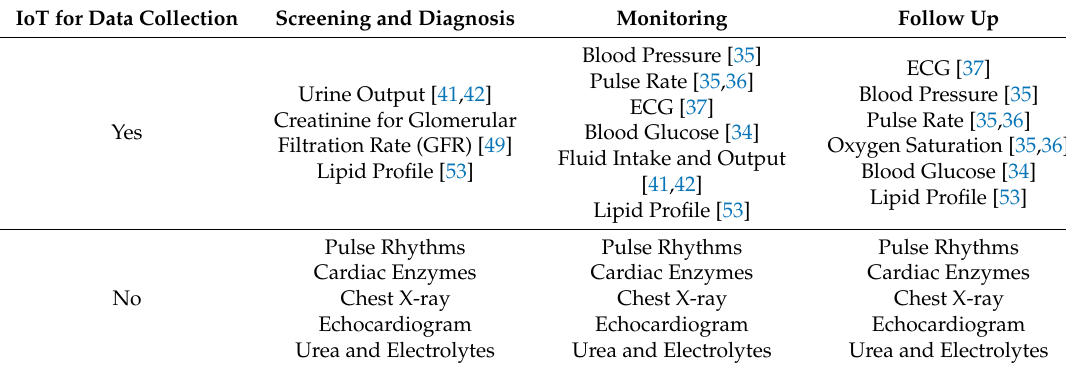
Table 6. Required data and IoT availability for chronic renal